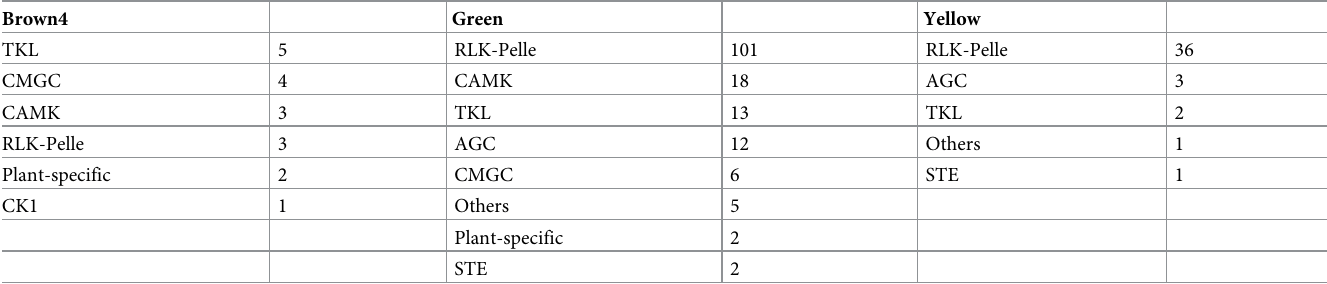
Hub genes were identified using Cytoscape software (Cytohubba plugin) and grouped by the MCC method (Fig 4). Table 5. PK families in the selected